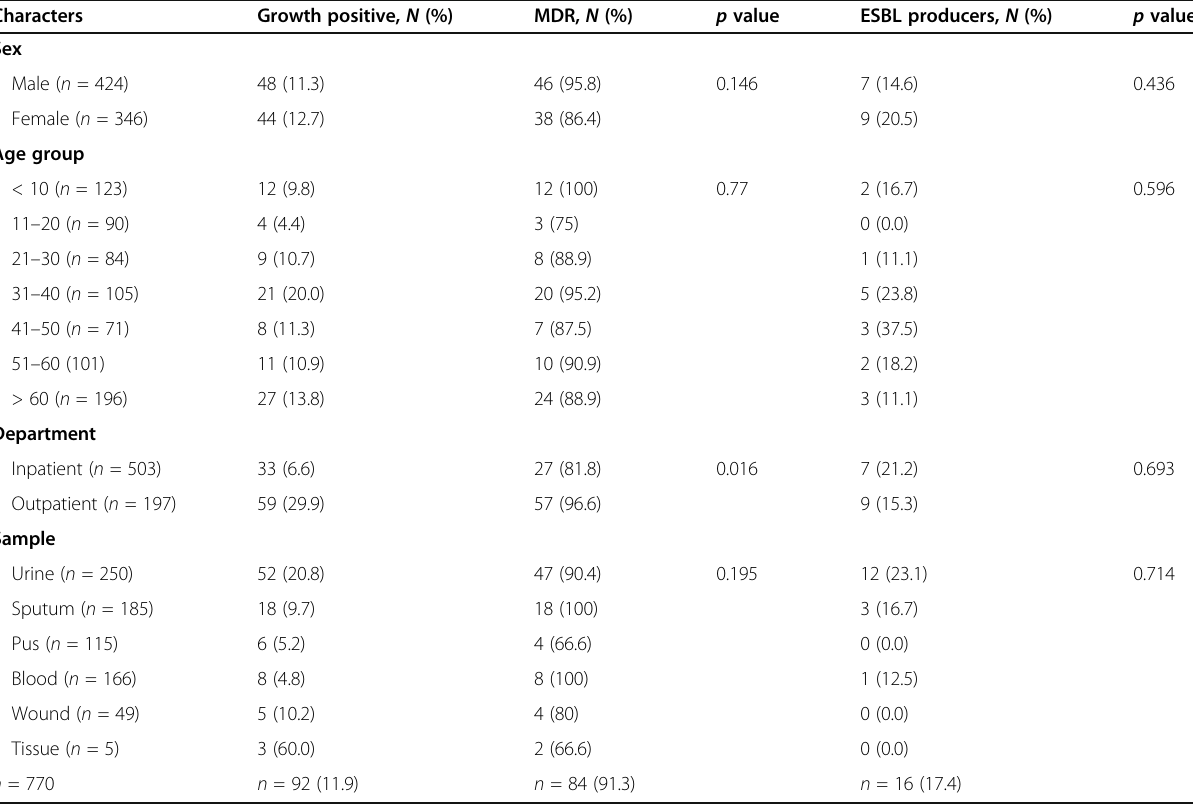
Table 3 Demographic distribution of MDR isolates and ESBL